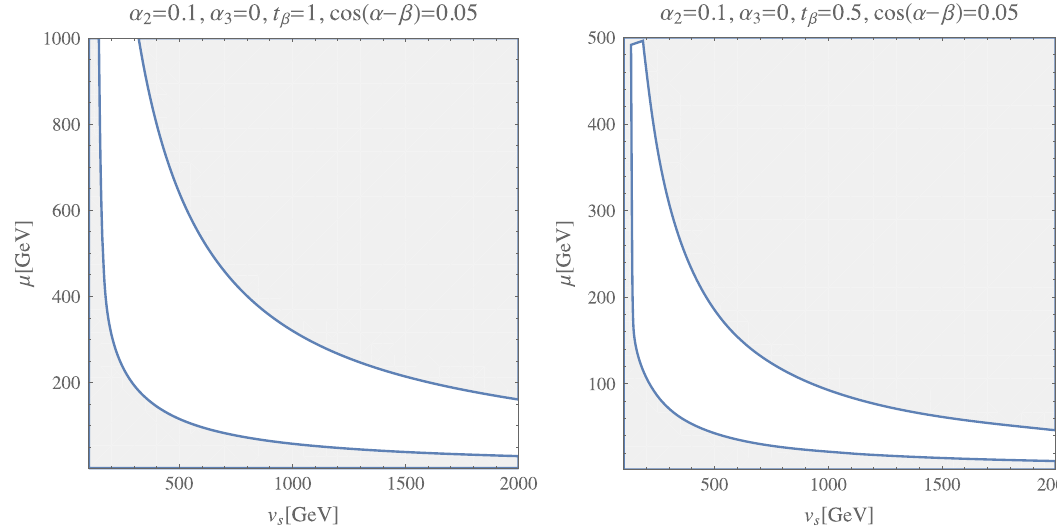
= m = m = 0 . 5 TeV and cos (α − β) = 0 . 05. The gray regions are excluded by unitarity h 2 H ± 3